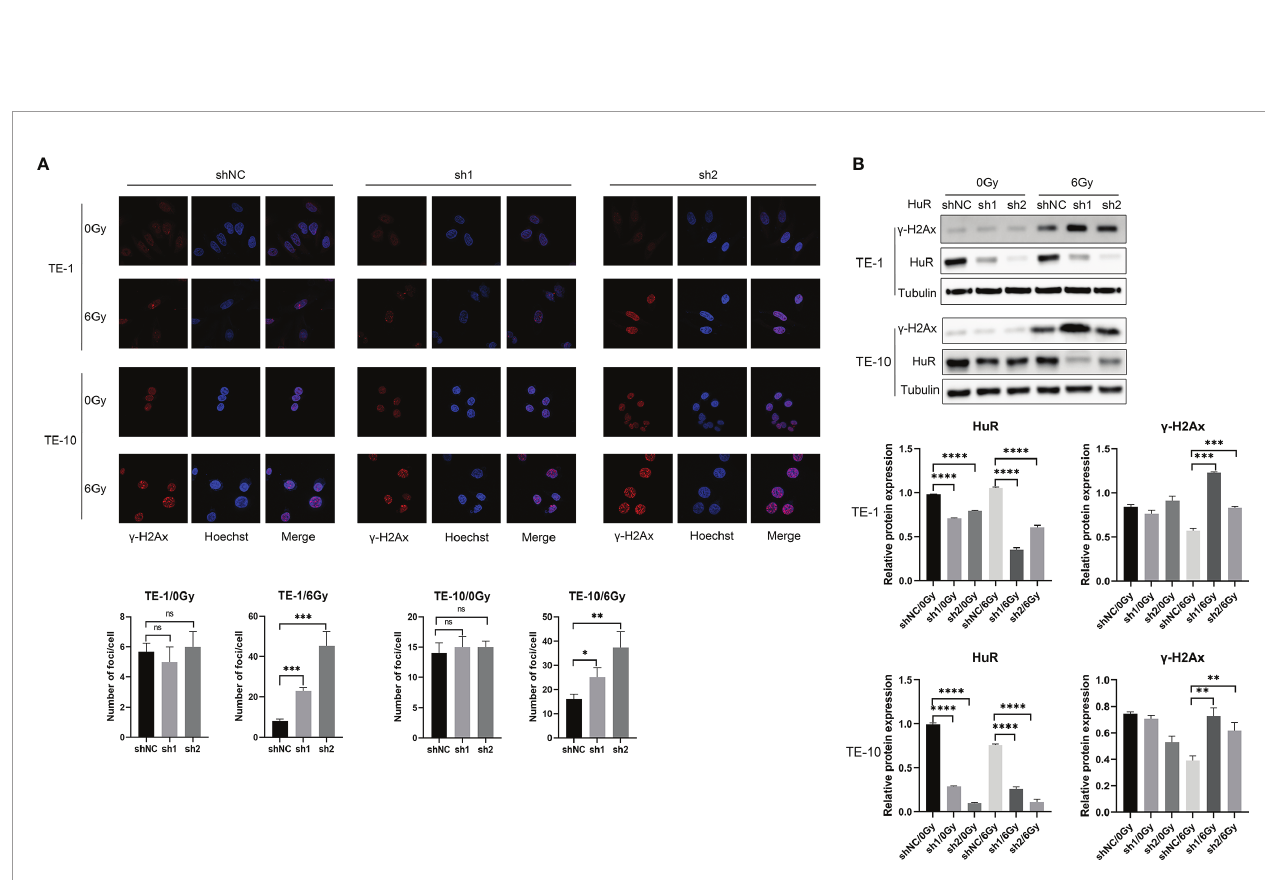
FIGURE 3 | HuR downregulation increased g -H2AX foci caused by X-ray irradiation and retarded DNA double strand breaks repair. (A) Immuno fl uorescence detection of g -H2AX foci of esophageal cancer cells exposed to 6Gy X-ray irradiation after HuR downregulaiton. (B) Expression of g -H2AX was determined by Western blot. ns >0.05, *p < 0.05, **p < 0.01, ***p < 0.001 and ****p <